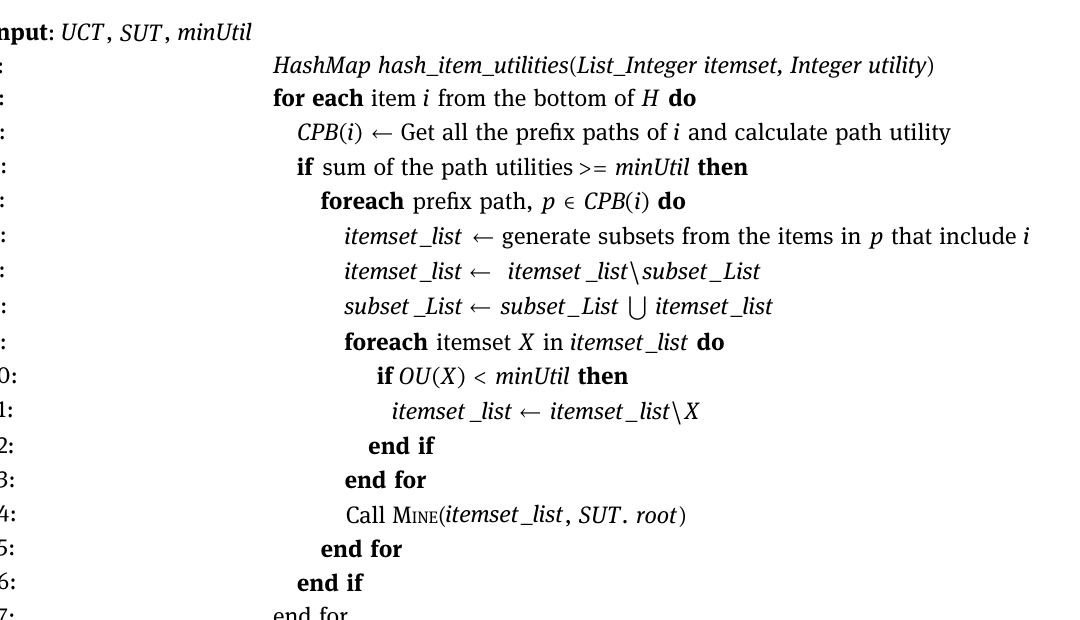
Figure 1: Utility Count Tree for database Table Algorithm 1 Single - phase utility computation algorithm – mining using UCT and SUT